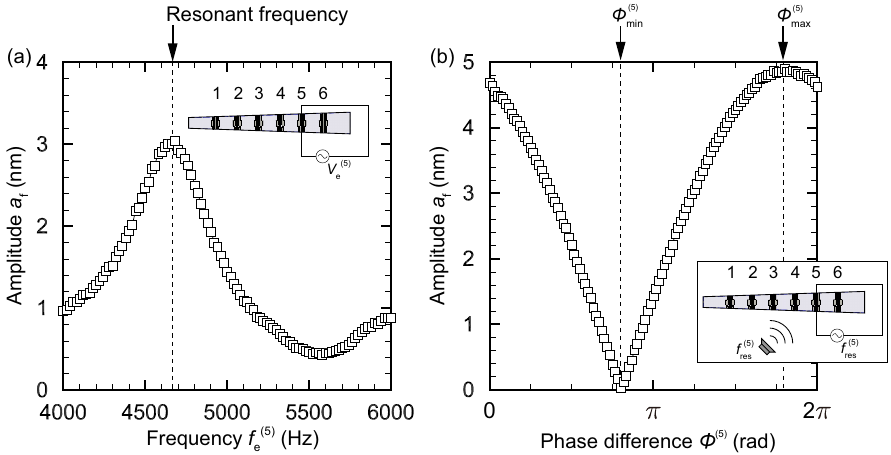
Figure 3. ( a ) Vibration amplitude at the fifth electrode ( x = 21 mm) for electrical stimuli applied ( 5 ) to the fifth electrode with frequency f e . The resonant frequency can be determined by sweeping ( 5 ) the frequency f e in Equation (1); ( b ) Phase dependence on the vibration amplitude at the fifth ( 5 ) ( 5 ) = f ( 5 ) electrode under sound stimuli with f s = f res and electrical stimuli with f e res . The amplitude ( 5 ) ≈ 1.8 π , while the amplitude is at a is at a maximum and a f ≈ 5 nm for a certain phase φ ( 5 ) = φ max ( 5 ) ≈ 0.8 π . The appropriate choice of φ ( i ) minimum and a f ≈ 0 nm for an another phase φ ( 5 ) = φ min leads to amplification or damping control of the membrane